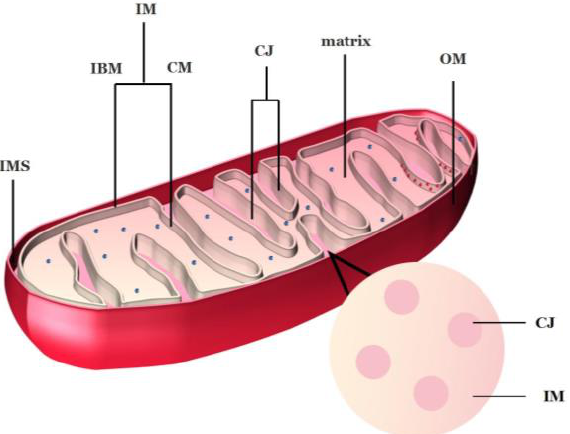
Figure 1. Mitochondrial structure of plants. IMS: intermembrane space; IM: inner membrane; CM: cristae membrane; CJ: cristae junctions; IBM: inner boundary membrane; OM: outer membrane. The blue spots in the matrix are ribosomes; the red spots in the CM are mitochondrial respiratory chain complexes. Image credit: Hui Tang.